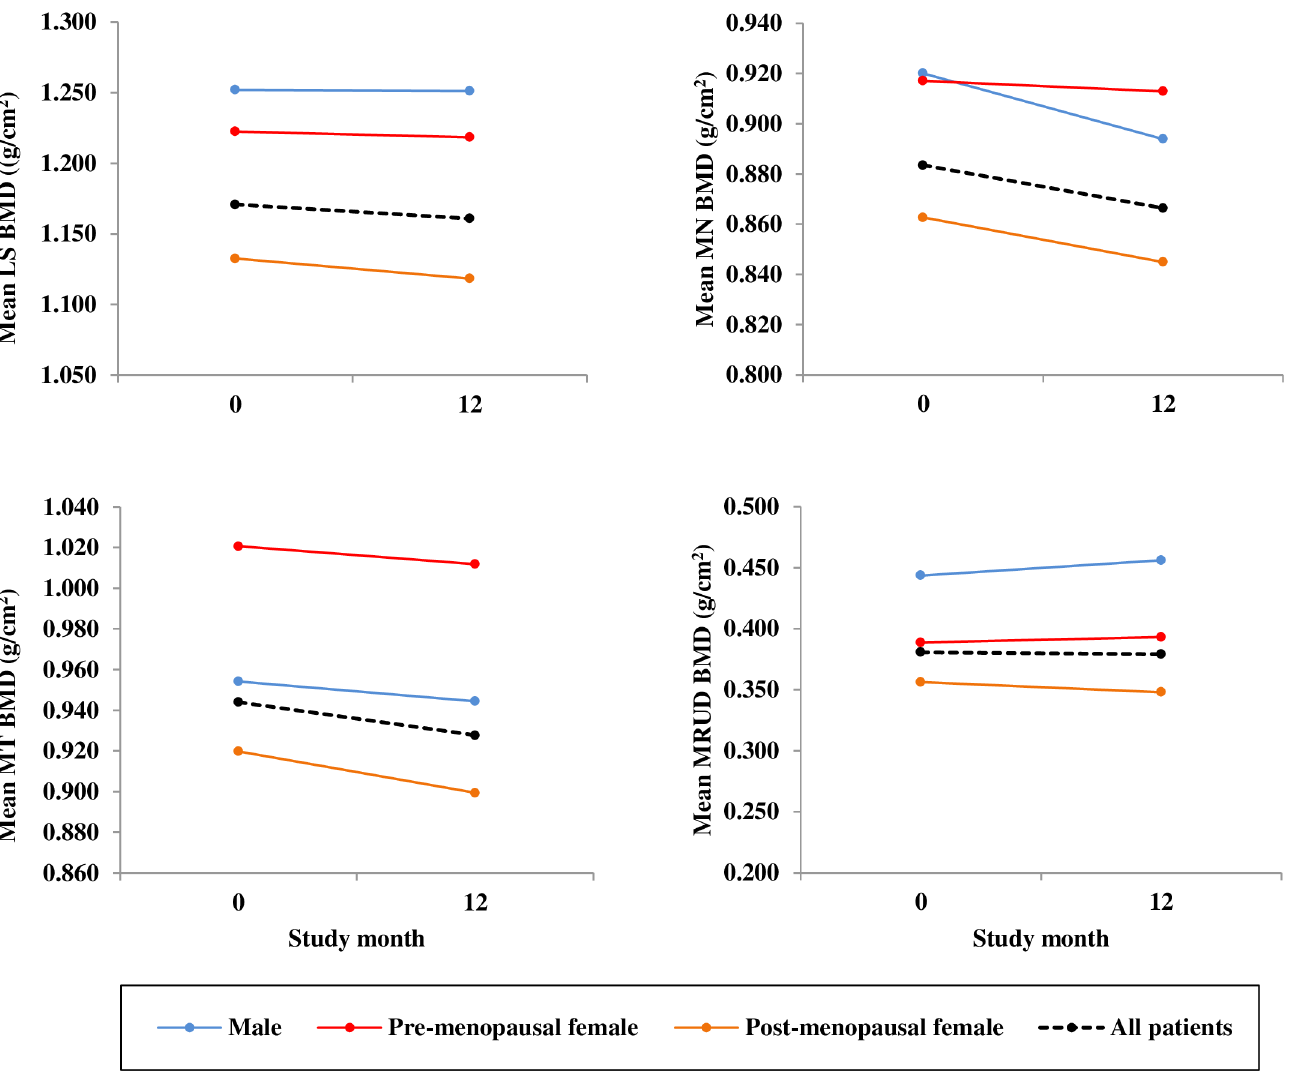
Fig 2. The effects of gender and menopausal status on mean bone mineral density. Bone mineral density (BMD) was plotted at lumbar spine; mean L2-L4 (LS BMD), also neck of femur (MN BMD), total femur (MT BMD) and ultra-distal radius (MRUD BMD) mean of both sides, at time 0 before the 1st rituximab infusion and after 12 months in patients who completed the study (n = 36). Patients were also stratified by gender and menopausal status (7 males, 6 pre- menopausal and 23 post-menopausal females).